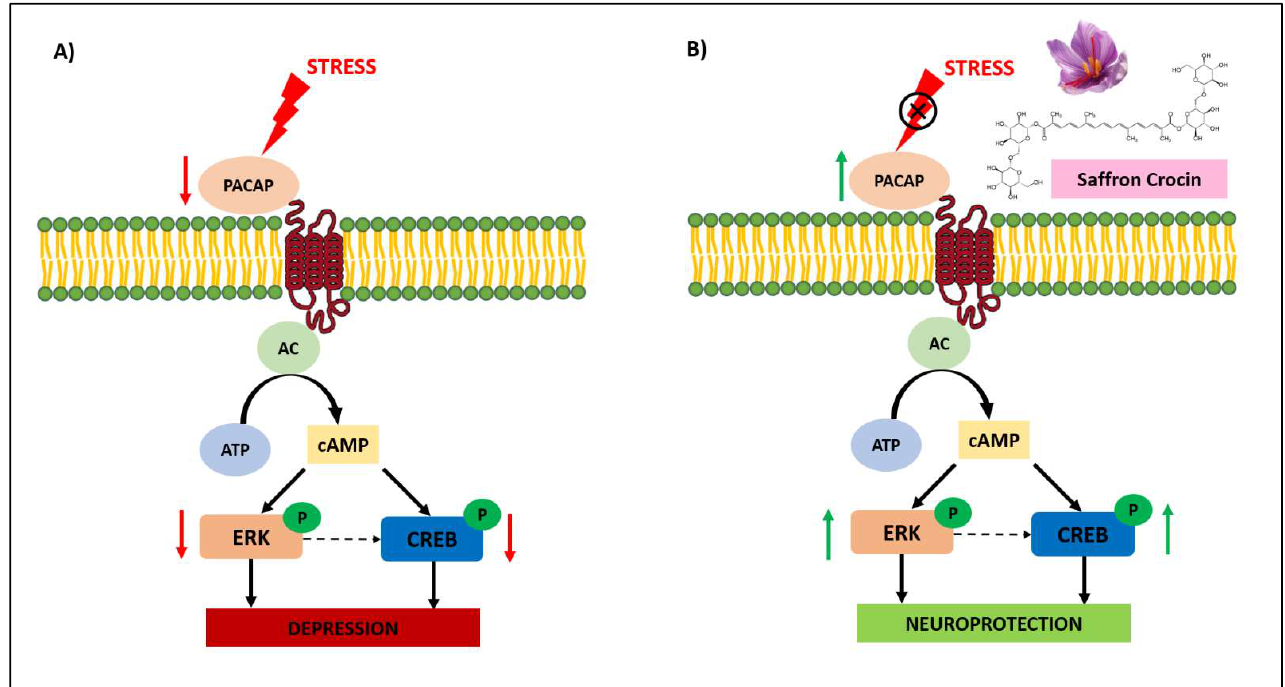
Figure 2. Mechanism for the neuroprotective effect of crocin in depression. Stress can cause depression ( A ), however, saffron crocin can reduce the effect of stress by exhibiting neuroprotection activity ( B ). PACAP, pituitary adenylate cyclase-activating polypeptide; ERK, extracellular regulated protein kinases; CREB, response element binding protein; cAMP, cyclic adenosine monophosphate; ATP, adenosine triphosphate; AC, adenylyl cyclase [98].